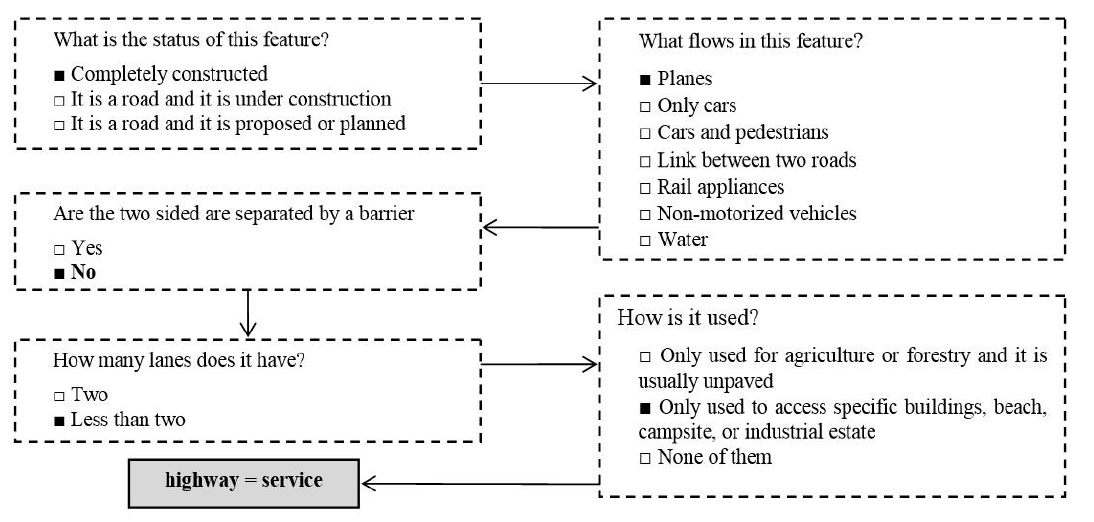
Figure 6. The questions and answers our hypothetical contributor has gone through to reach the highway=service